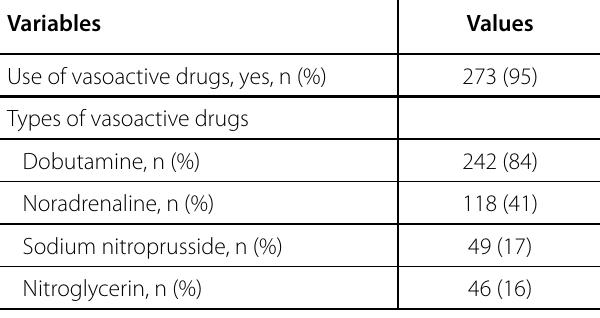
Table 3 . Vasoactive drugs